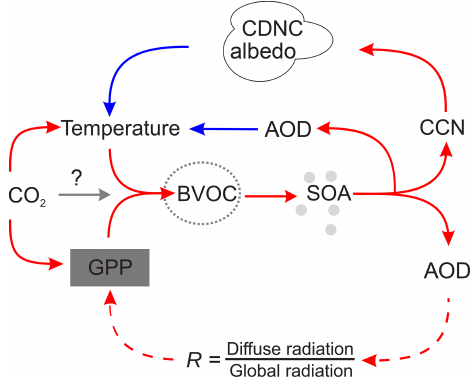
Figure 12. Our modified version of the BVOC feedback according to the results from this study. The red arrows in the figure indicate that if the variable at the start of the arrow increases, then the vari- able at the end of the arrow is also expected to increase. A blue arrow on the other hand means that an increase in the variable at the start of the arrow is expected to result in a decrease in the vari- able at the end of the arrow. The GPP branch of the feedback now has dashed lines and the changed AOD has been found to impact